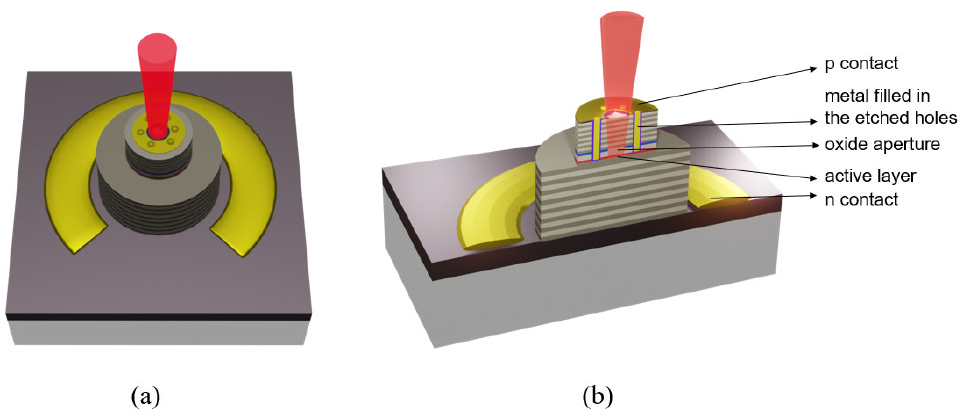
Figure 9. ( a ) Schematic of MuHA VCSELs. ( b ) Schematic cross ‐ section of MuHA VCSELs.